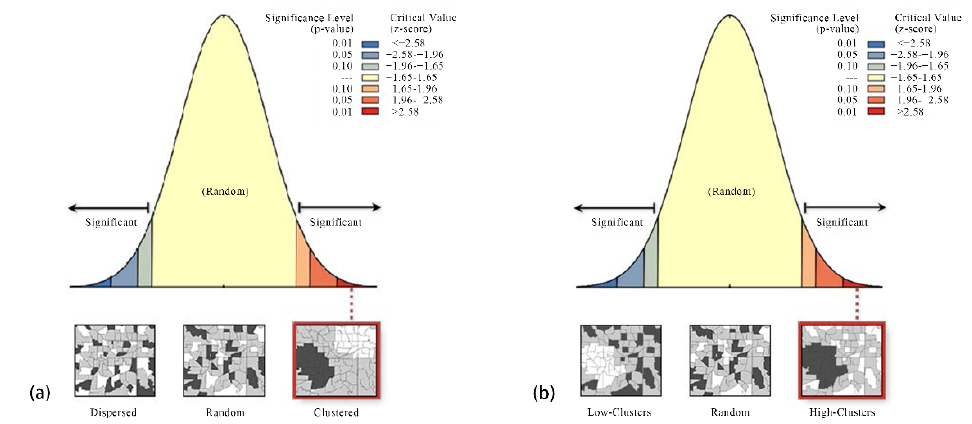
Figure 4. Results of spatial autocorrelation analysis: ( a ) Moran’s I results; ( b ) general G results). Table 1. List of Moran’s I and General G analysis results.